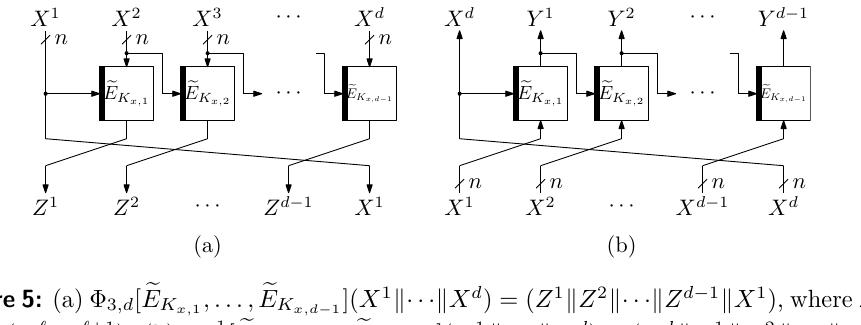
Figure 5: (a) Φ 3 ,d [ e E K